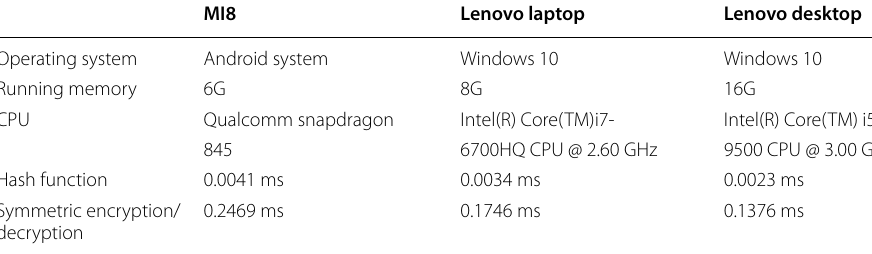
Table 5 Configuration and running time of equipment MI8 Lenovo laptop Lenovo desktop